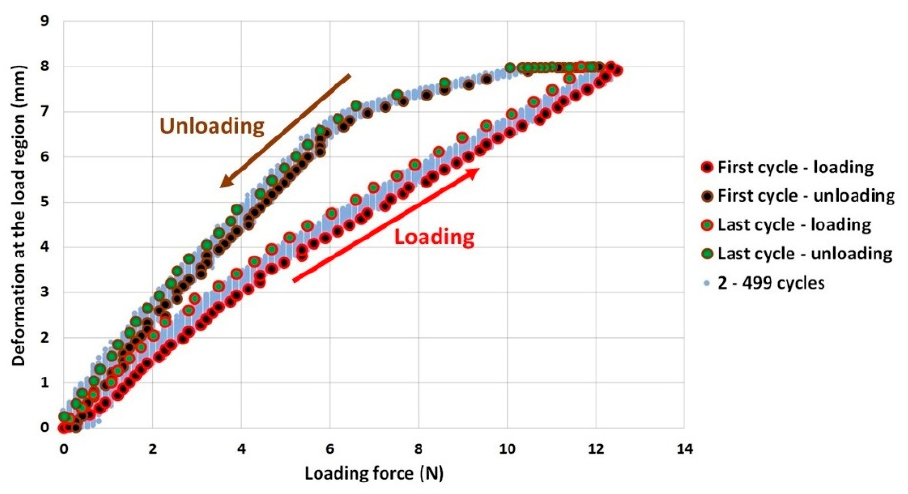
Figure 16. Hysteresis for structure B with a wall thickness of 2.8 mm.